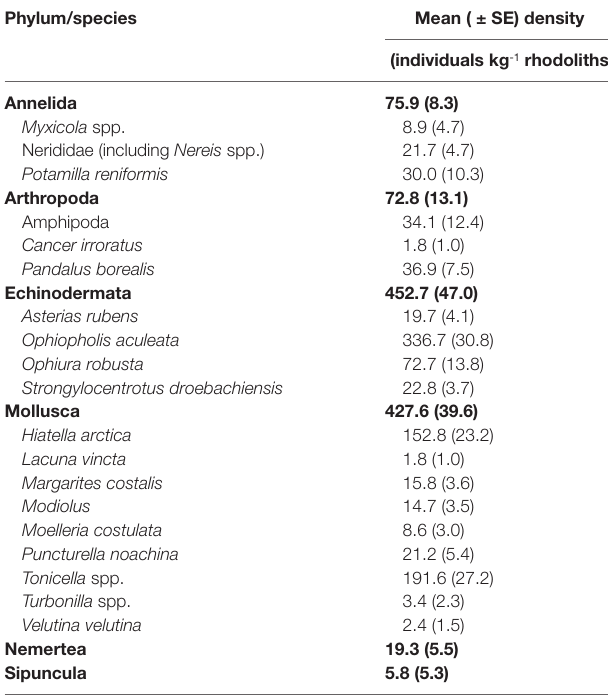
TABLE 1 | Taxonomical breakdown and abundance of invertebrate cryptofauna associated with rhodoliths ( Lithothamnion glaciale ) collected in April 2017 at the South site (see Figure 1A